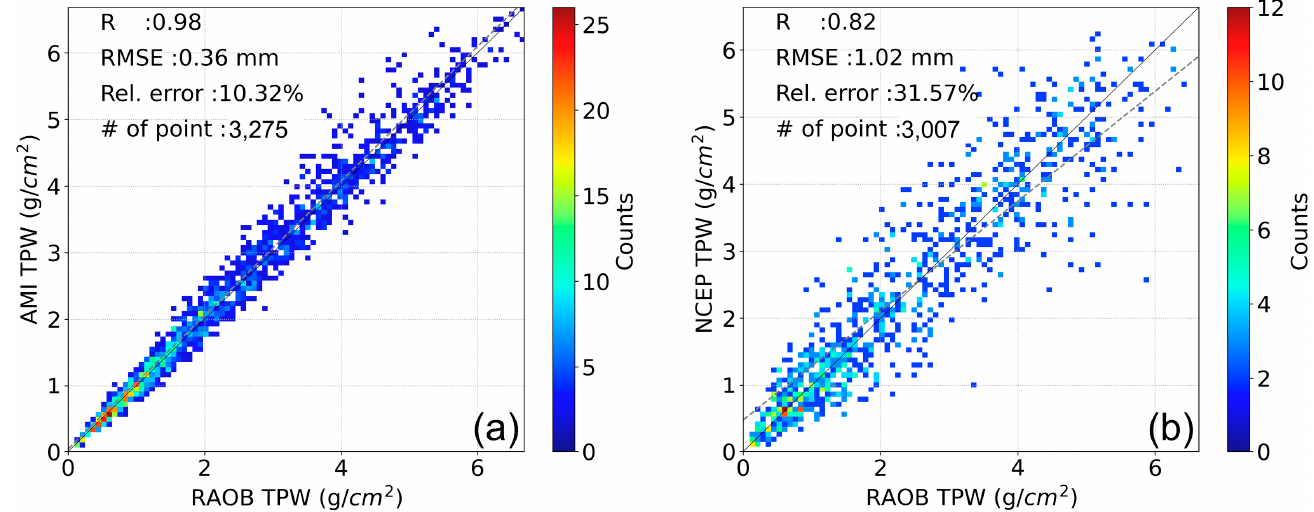
Figure 2. Scatter plot of radiosonde total precipitable water (TPW) observations, and ( a ) advanced meteorological imager (AMI) and ( b ) National Centers for Environmental Prediction (NCEP) TPW data. Color gradient indicates the number of data points in 0.065 × 0.065 bins. Rel. error refers to mean absolute percentage error. Solid and dash lines indicate the 1:1 line and regression line, respectively. “# of point” means the number of data.